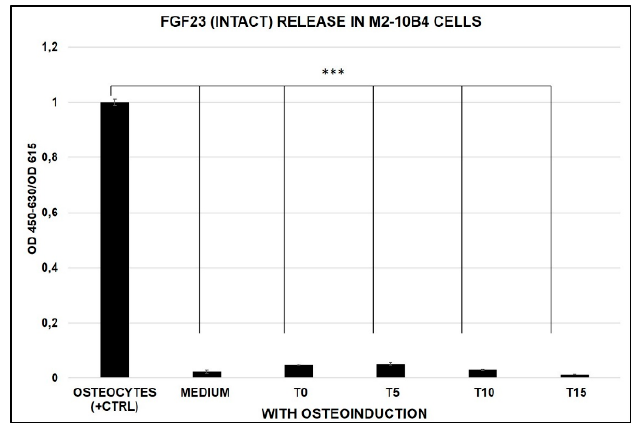
Figure 6. Intact FGF23 release in cell cultured medium harvested from OS (control positive) and M2-10B4 during the osteogenic induction (T0–T15): *** p < 0.001.